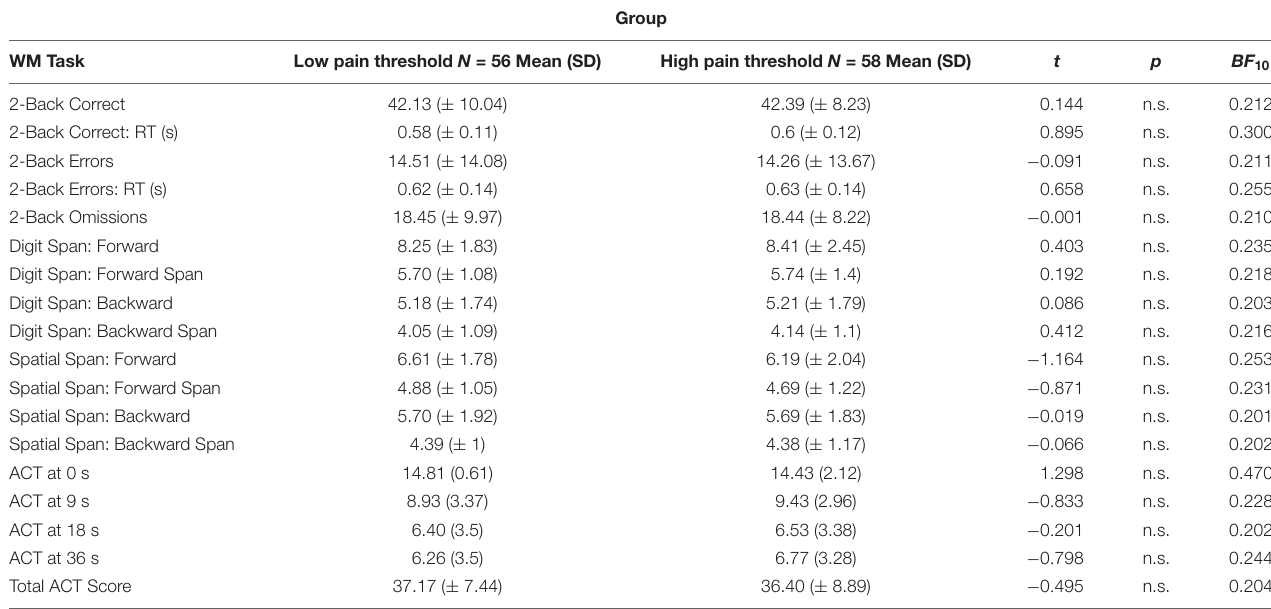
TABLE 3 | Results in working memory tasks for the “low pain threshold” and “high pain threshold” groups